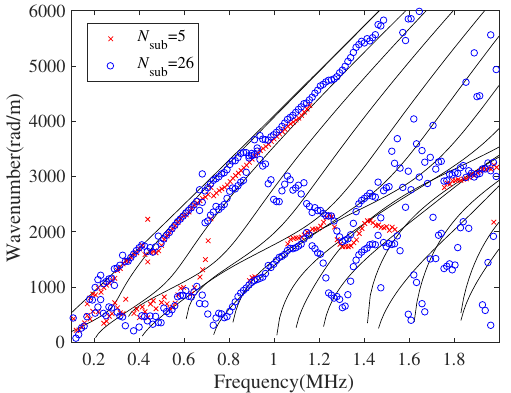
Figure 11. Wavenumbers estimated for differently sized sub-arrays. Red cross marks and blue circles show the results obtained for N sub = 5 and 26, respectively. Black lines show the theoretical